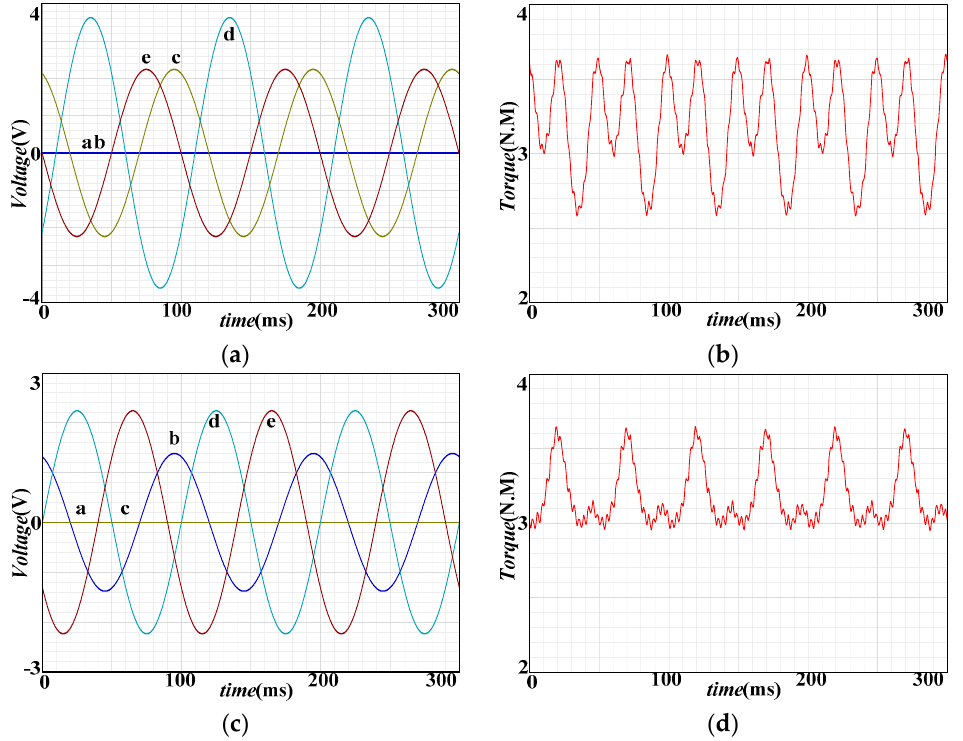
Figure 10. Fault-tolerant current and torque waveforms with double open-phase condition: ( a ) current of AB fault-tolerance; ( b ) torque of AB fault-tolerance; ( c ) current of AC fault-tolerance; ( d ) torque of AC fault-tolerance.